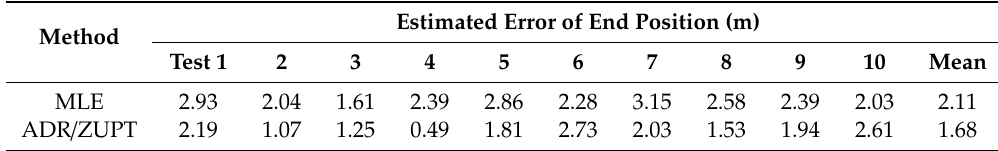
Figure 8. Straight line experiments scene based on foot-mounted IMU array. Table 1. Estimated error of end position in straight line